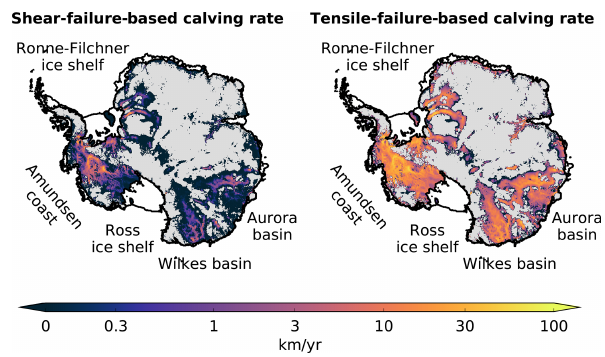
Figure 1. Potential shear-failure-based calving rates (Eq. 16) and tensile-failure-based calving rates (Eq. 15) in the grounded, marine regions of the Antarctic ice sheet. Floating ice is shown in white and grounded ice above sea level in grey. In the marine regions, ice is assumed to be at floatation thickness, which gives a minimal estimate of the potential calving rates. Estimates for shear calving rates go up to 65kma − 1 , and estimates for tensile calving rates go up to 75kma − 1 . If the grounding line retreat is faster than the speed with which the glacier terminus thins to floatation, calving rates could be even larger. Imposing an upper bound on the calving rates is necessary to prevent unrealistic, runaway ice